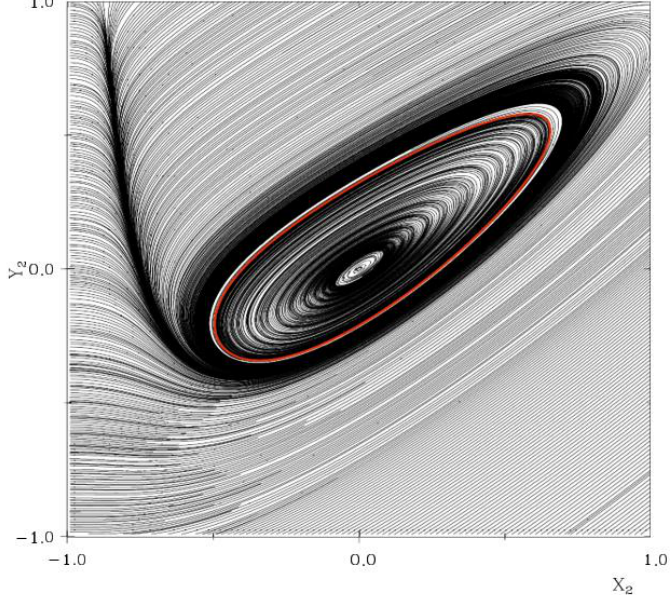
Figure 1. (black line) Streamlines of Equation (1) in the phase space ( X 2 , Y 2 ). The fixed point (0, 0), which corresponds to the boundary layer quasi-equilibrium, is unstable. The red line represents a limit cycle that corresponds to a quasi-two-day oscillation in the tropics.